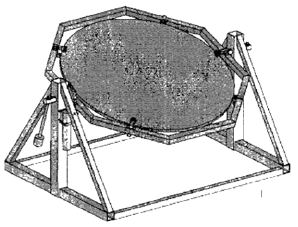
Figure 7. Octagonal structure designed by Ljubicic in 2006.